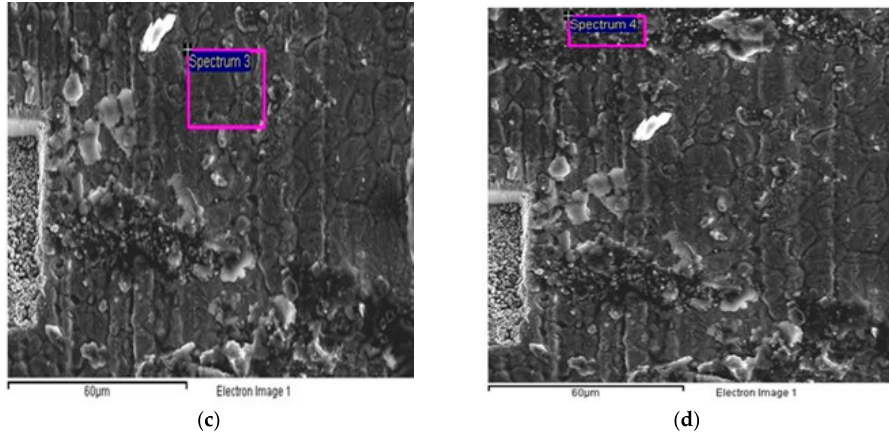
Figure 6. Selected sites on SS316L sample surface for EDX analysis: ( a ) Sample location 1; ( b ) Sample location 2; ( c ) Sample location 3; ( d ) Sample location 4. Table 5. EDX chemical analysis, weight percentage of SS 316L sample surface after 100 h testing.